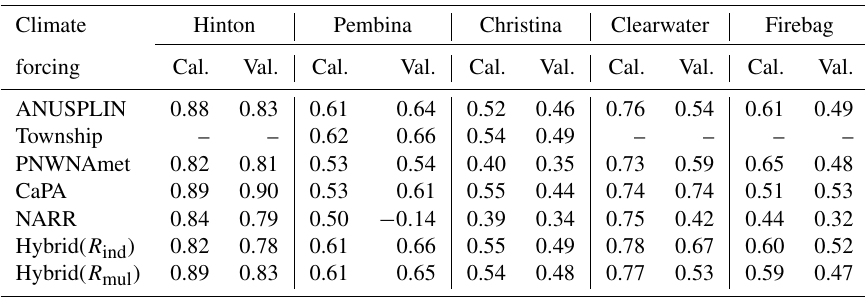
Table 7. NSE values between the current study and literature for the Athabasca River basin. The NSE values were obtained for calibration and validation periods. For comparison of the current study to the literature, the NSE values of the current study were obtained from the VIC simulation for the hybrid climate dataset ( R ind ).